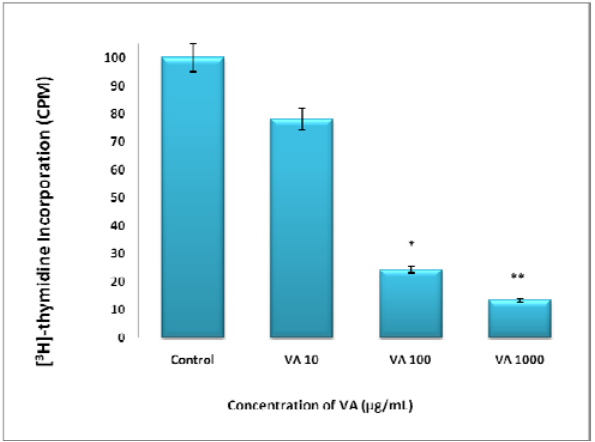
Figure 2: Inhibition of DNA synthesis of BT-549 cells by VA extracts. Log phase proliferating cells were treated for DNA synthesis with various concentrations of VA (10 or 1000 µg/mL) for 18 h followed by 6 h treatment of 1 µCi/ mL [ 3 H] thymidine. Uptake was determined as described under materials and methods. Each data point represents the mean ± SD of three independent experiments. *P<0.05 ;**P<0.01.